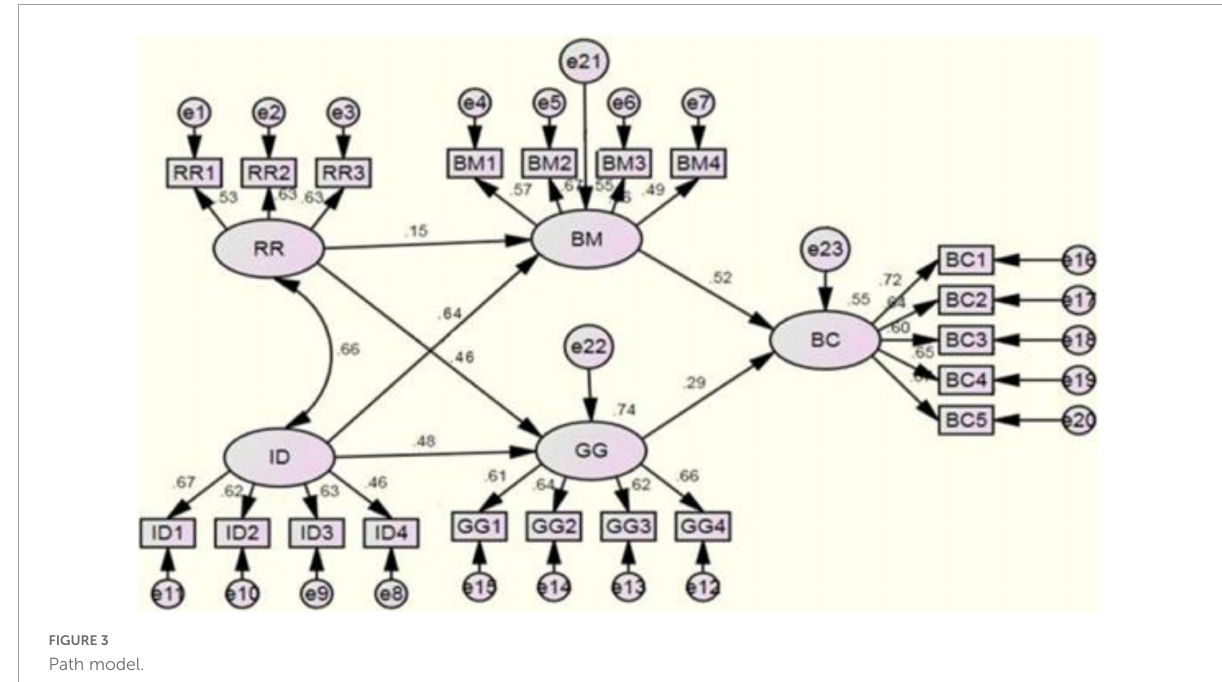
FIGURE3 Path model.